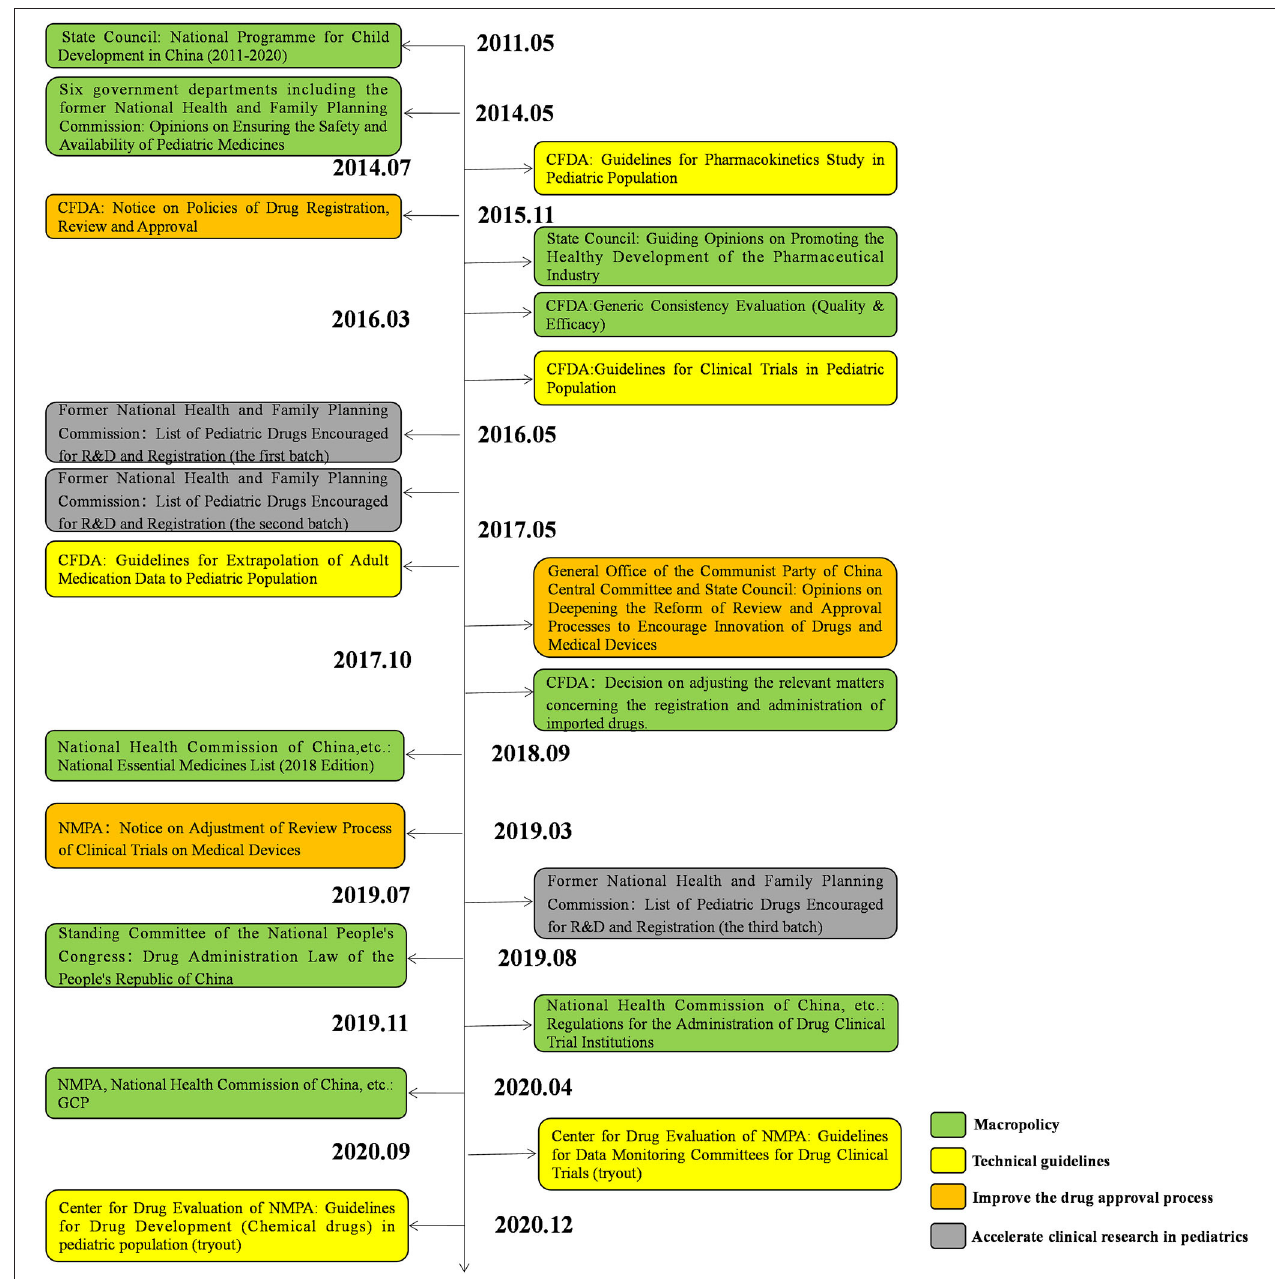
FIGURE 11 | Policies and